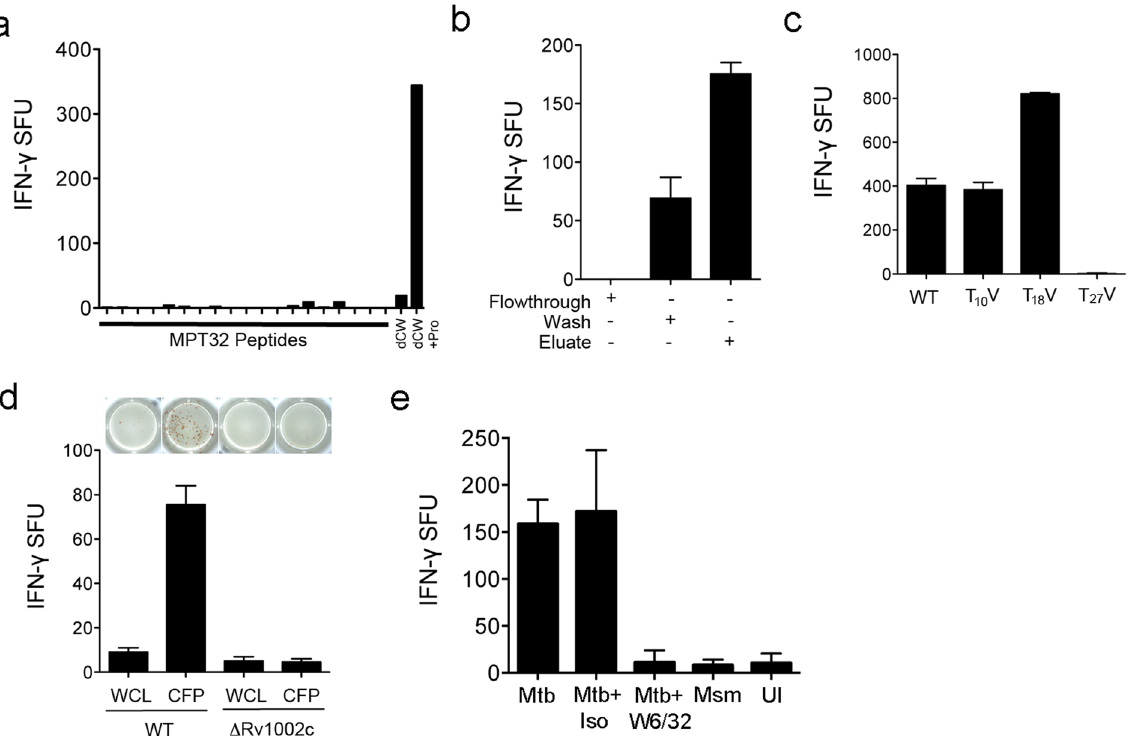
Figure 3. Native MPT32 glycosylated peptides are antigenic. ( a – d ) DC were pulsed with the following samples and used as antigen presenting cells in an ELISPOT assay with IFN- γ release (spot forming units (SFU)) by the HLA-E restricted T cell clone, D160 1–23, as a readout. ( a ) Synthetic overlapping peptides representing Mpt32. ( b ) Flow-through, wash, and eluate following concavalin-A column enrichment of pronase-digested native Mpt32. ( c ) Pronase-digested CFP from the Mpt32 T 10 V, T 18 V, and T 27 V recombinant Mtb strains. ( d ) Pronase digested whole cell lysates and culture filtrate proteins from wild-type Mtb or the Δ Rv1002c Mtb mutant. ( e ) DC were infected with M . smegmatis (Msm) or Mtb as a positive control or left uninfected (UI) and used as antigen presenting cells in an ELISPOT assay with IFN- γ release (spot forming units (SFU)) by the HLA-E restricted T cell clone, D160 1–23, as a readout. Blocking with the W6/32 antibody is shown for Mtb infected cells. Results are the mean and standard deviation from four independent